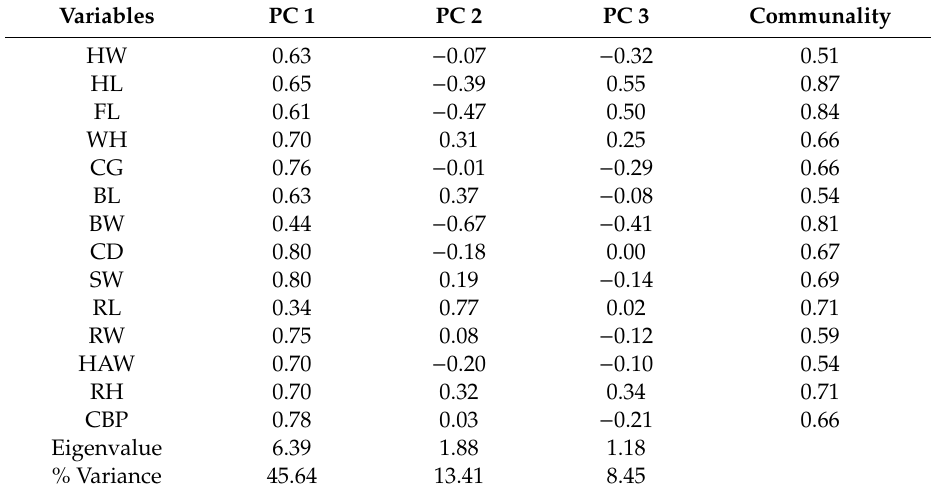
Table 4. Eigenvalues, proportion of total variance, and correlations between variables and principal components (PCs) in the Black Creole